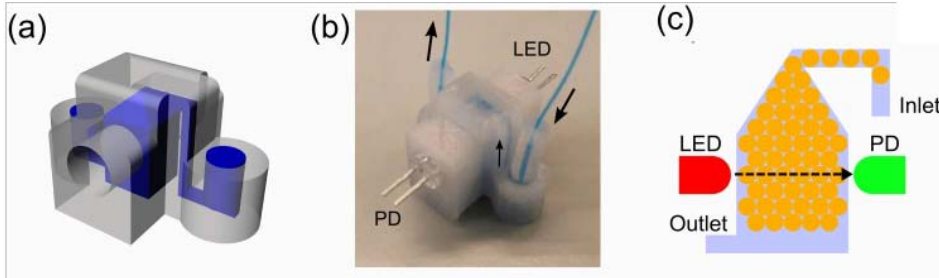
Figure 20. ( a ) Droplet storage and growth measurement device CAD design; ( b ) Fabricated device with LED and photodiode (PD) sensor attached; ( c ) Scheme of droplet cell growth monitoring. (Reproduced with permission from [24].)